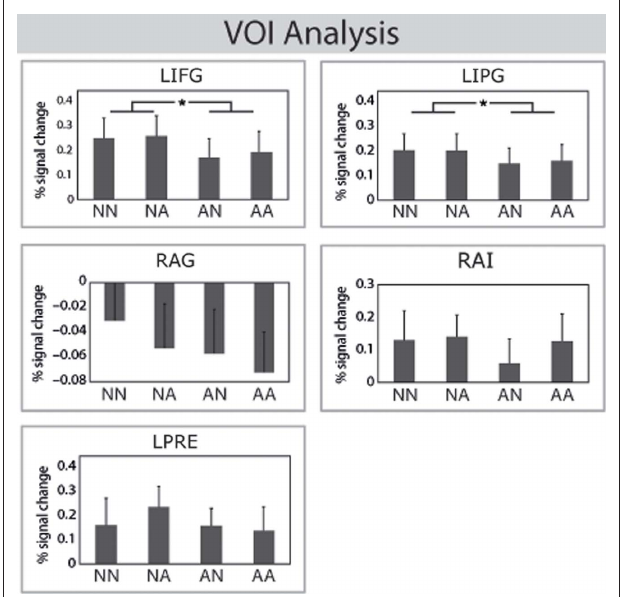
FIguRE 4 | Volume of interest analysis. Top : The VOI analysis in left IFG and left IPG corroborated the findings of the ANOVA. The BOLD response for negations was higher than for affirmations in the main clause. Bottom : The VOI analysis in the right angular gyrus (RAG) revealed more deactivations for affirmations in comparison to negations. The effect in the left precentralis (LPRE) and right anterior insula (RAI) reached not significance.